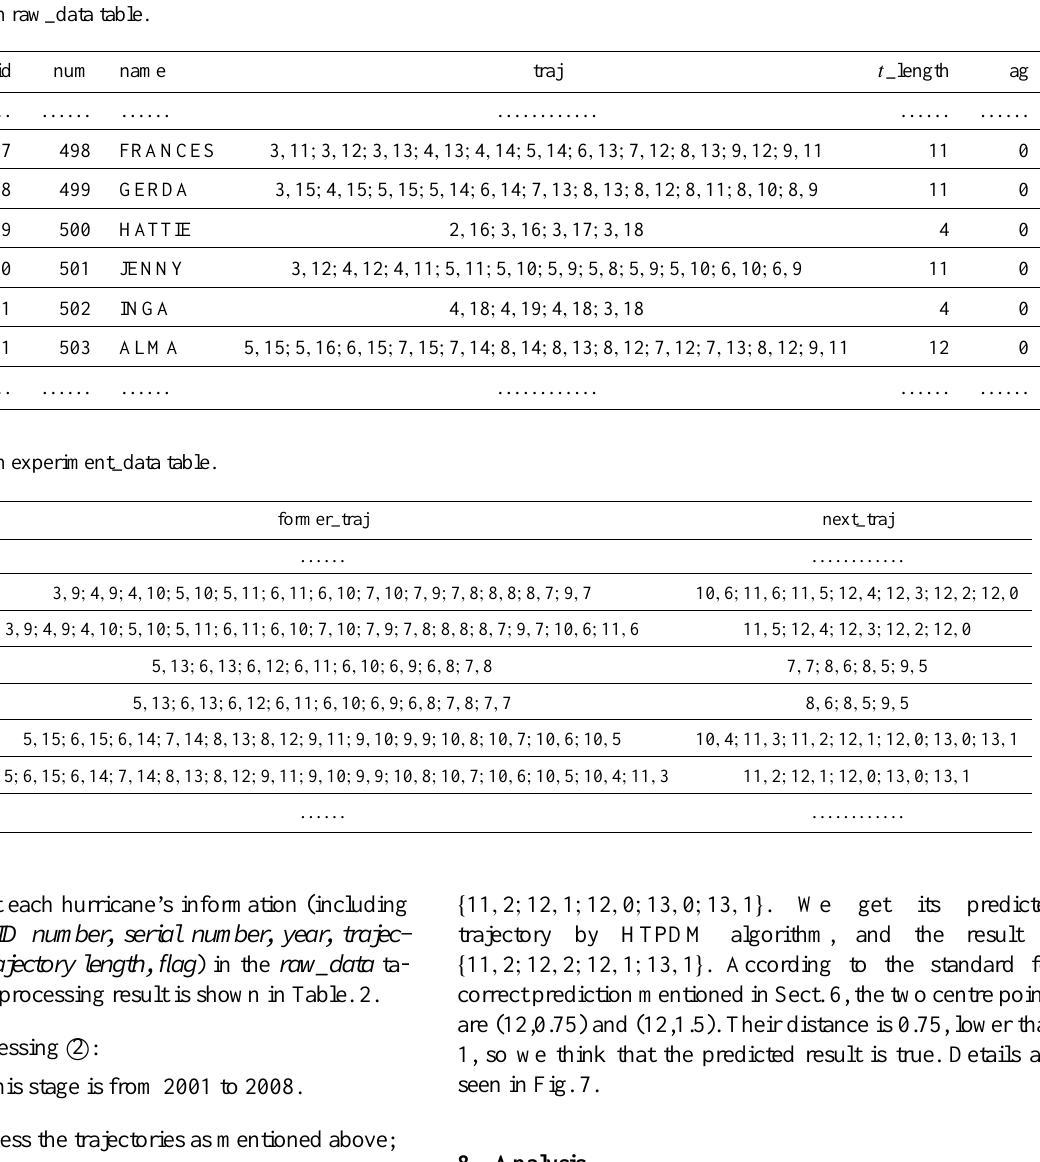
Table 2. The datum in raw_data table.